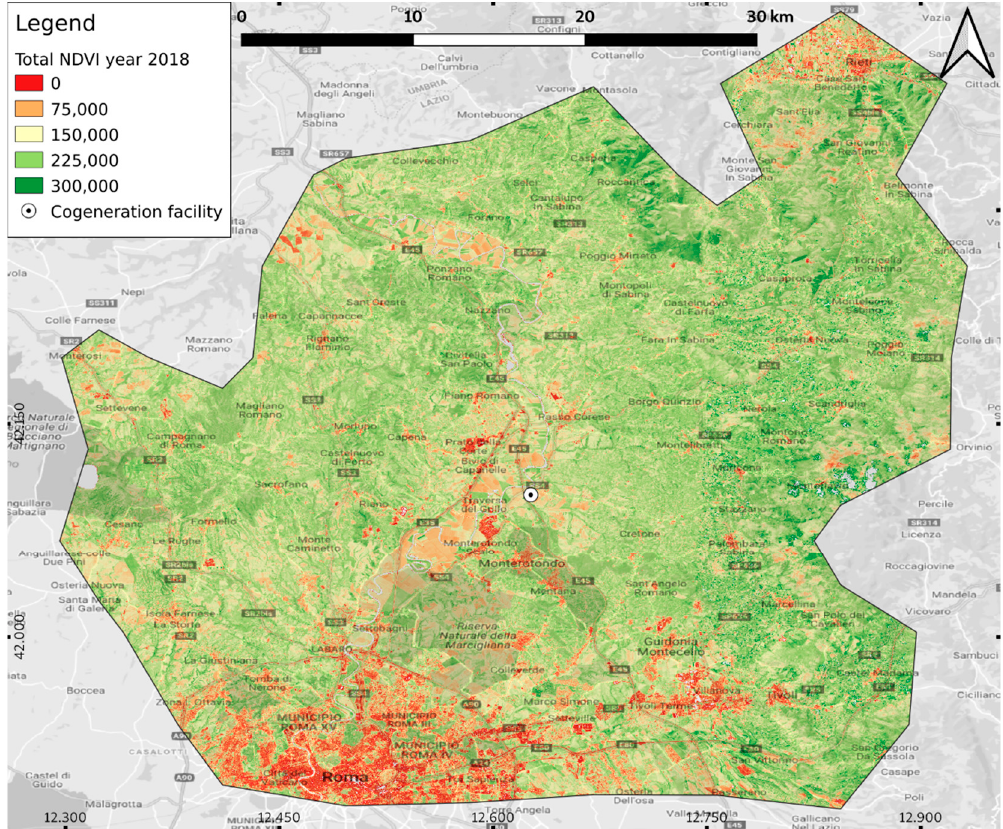
Figure 5. Spatially explicit map of the normalized difference vegetation index for 2018 used as the auxiliary variable in RSS over the study area. The red-colored area corresponds to urban built areas (NDVI close to 0), greenest colors denote highly stocked vegetated areas such as broad-leaved forests (NDVI close to 300,000).